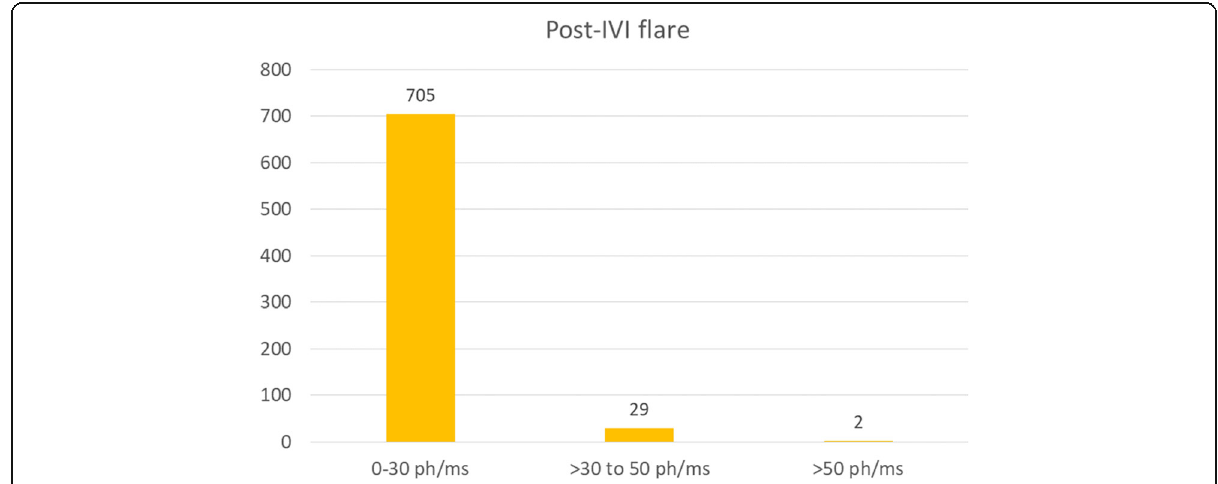
Fig. 1 Distribution of laser flare photometry values after 72 h of intravitreal